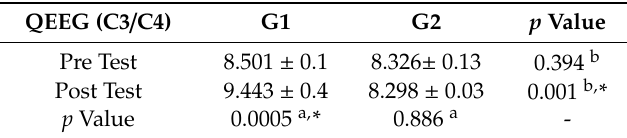
Table 4. The mean values of peak frequency of alpha wave of motor areas (C3 / C4) of the a ff ected hemisphere in both